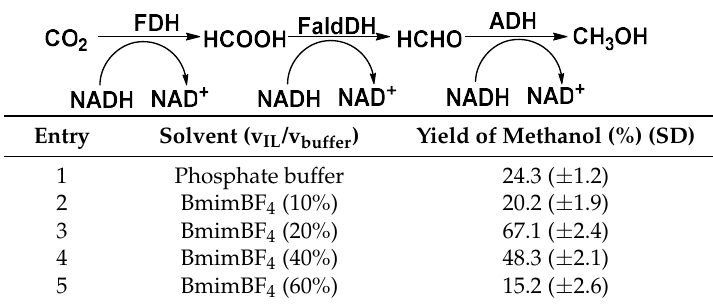
Table 4. Enzymatic Conversion of CO 2 to Methanol b .